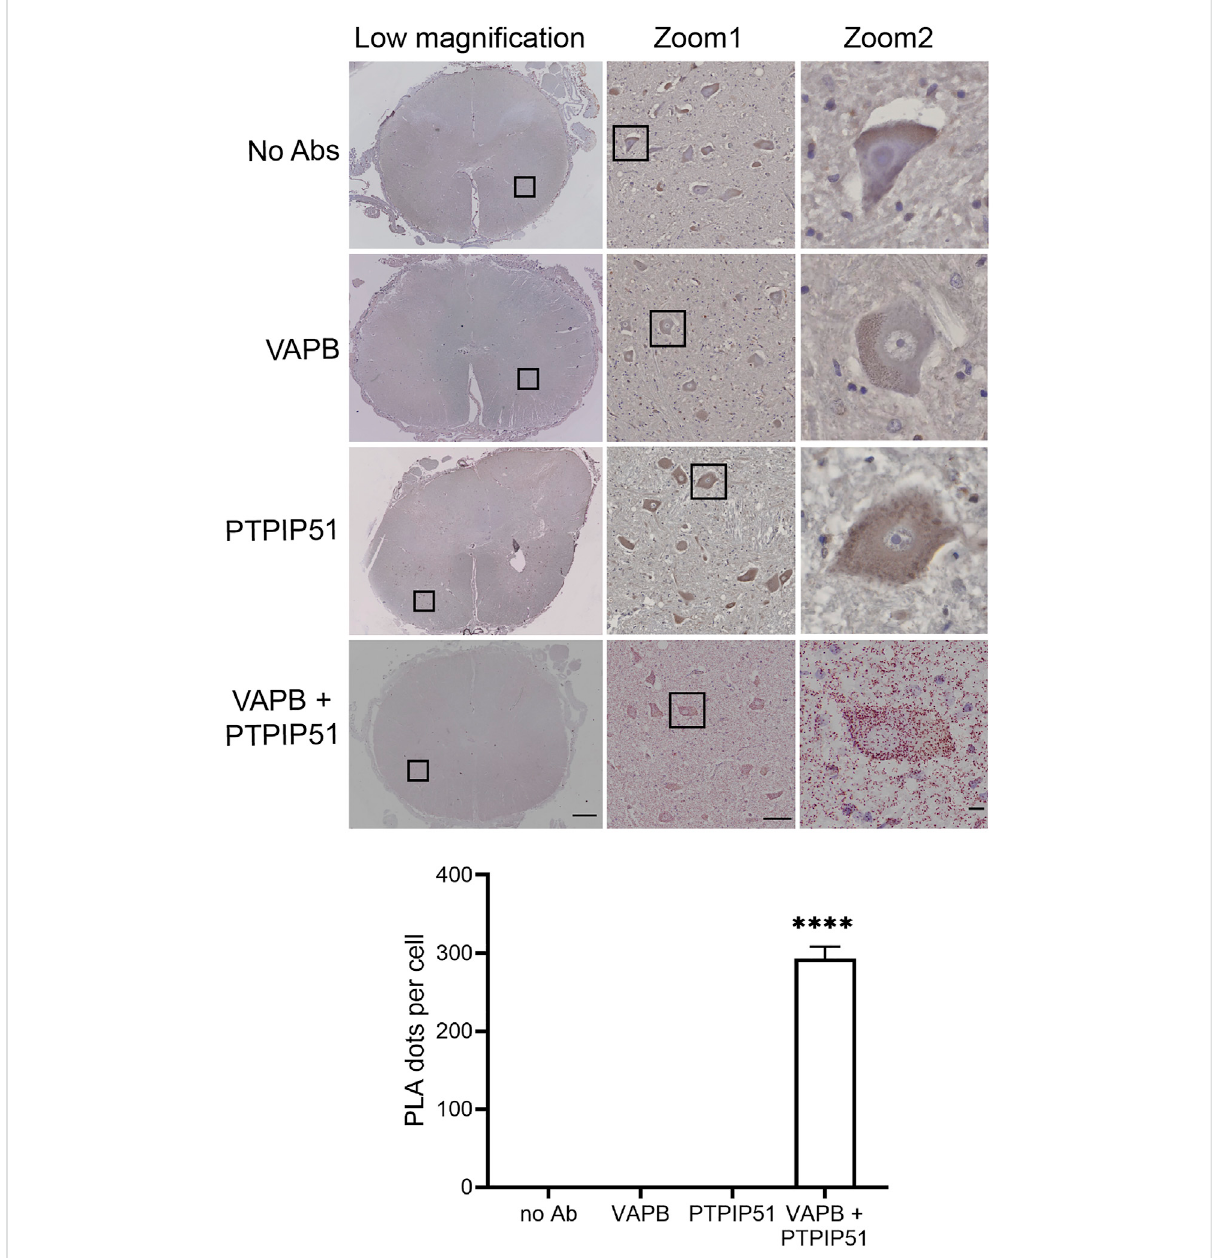
Control experiments demonstrating the speci fi city of VAPB-PTPIP51 PLAs on human post-mortem spinal cord tissues. Controls involved omission of VAPB, PTPIP51, or both VAPB and PTPIP51 primary antibodies (no primary Ab). The graph shows the number of PLA dots per spinal cord motor neuron inthe different experiments.Data wereanalysed by ANOVA and Tukeypost hoc test. N = 20 – 106 per condition, error bars are s. e.m.; **** p < 0.0001. Scale bars: 1,000 μ m (Low magni fi cation), 100 μ m (Zoom 1) and 10 μ m (Zoom